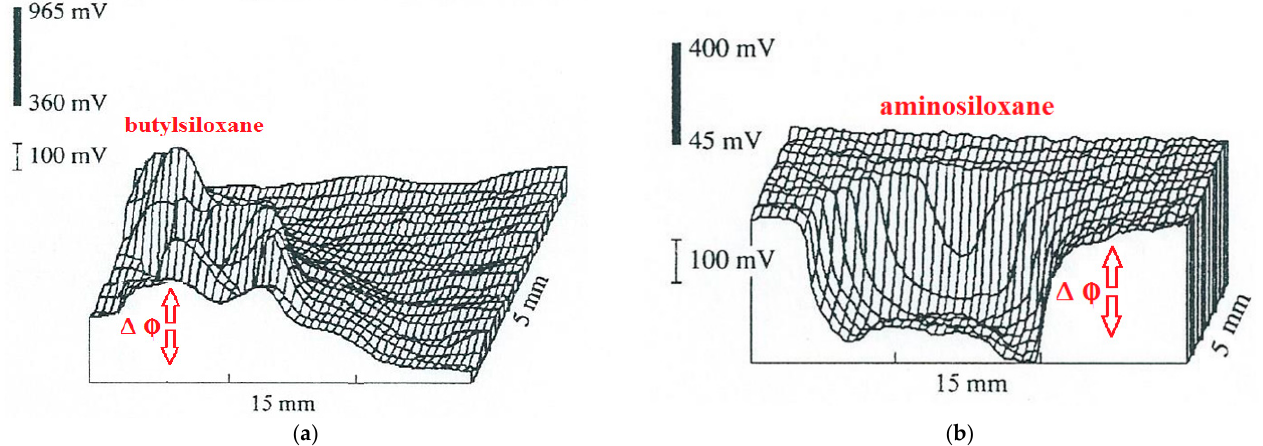
Figure 8. Potential distribution above iron surface with local deposits of BTMS ( a ) and ATMS ( b ) siloxanes [22]. SKP measurements were performed in ambient air at 60% RH and the potential is given vs. standard hydrogen electrode (SHE). Published with permission from Pleiades Publishing, Ltd.